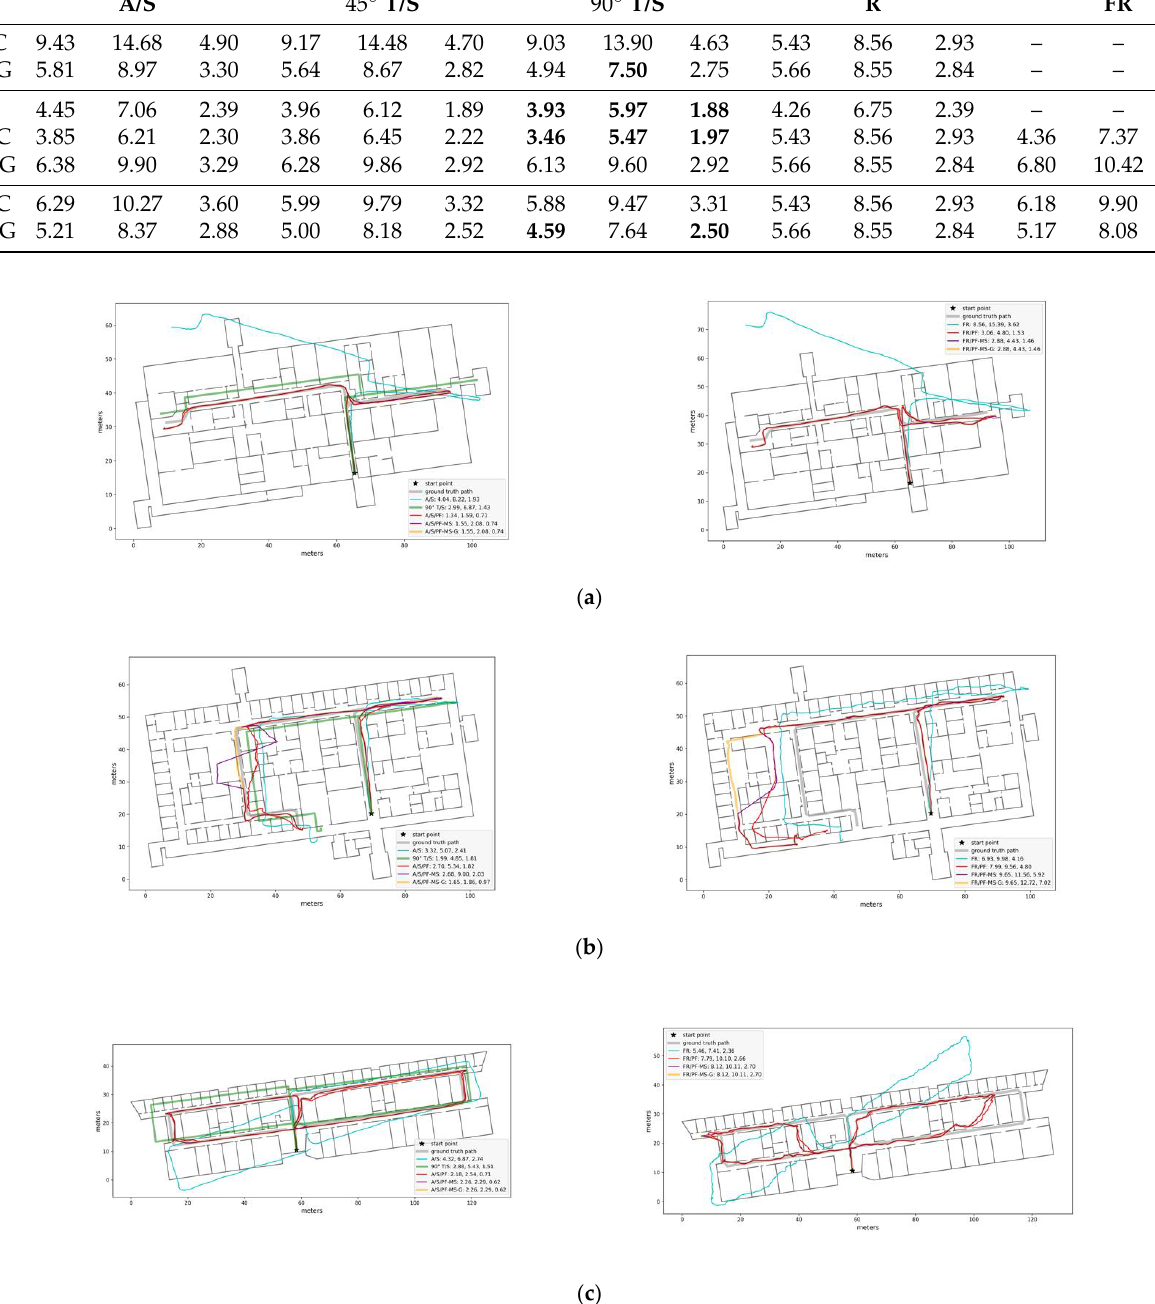
Figure 9. Examples of path reconstruction from the TA:LC training/test modality. Left: Map-less: A/S, 90° T/S; Map-assisted: A/S-PF, A/S-PF-MS, A/S-PF-MS-G. Right: Map-less: FR; Map-assisted: FR-PF, FR-PF-MS, FR-PF-MS-G. Reconstruction errors for the three metrics (RMSEwp, Hauss, avHauss) are shown (in units of meters) in the legend of each figure. ( a – c ) refer to different buildings.